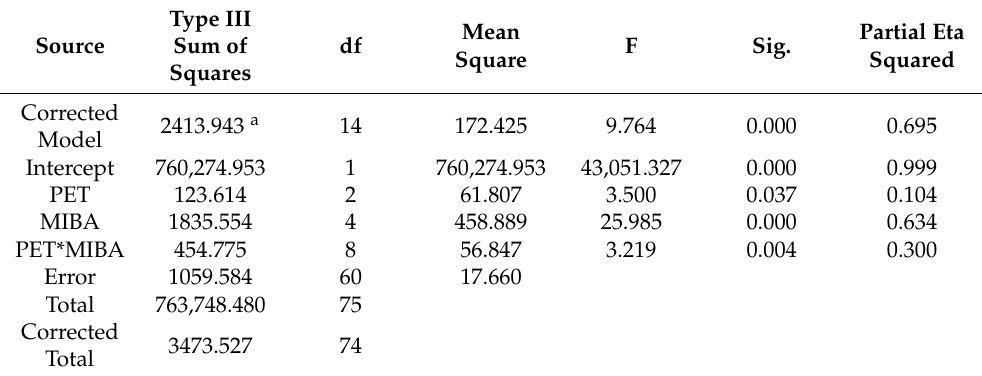
Table 5. Water absorption tests between PET pellets and MIBA effects. Test of Between-Subjects Effects. Dependent Variable: Water absorption.